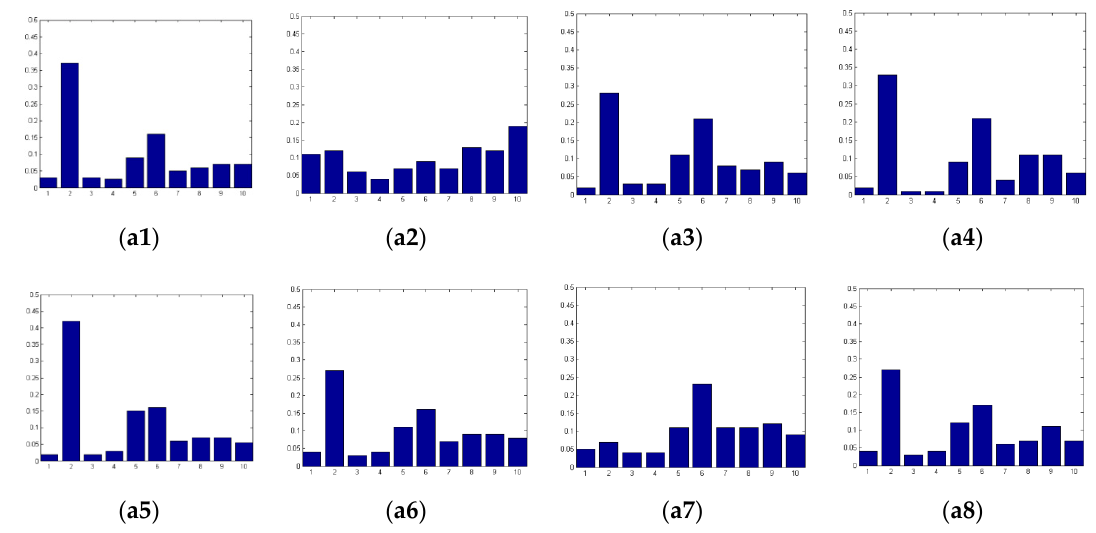
Figure 7. The examples of texture features of pictorial regions in the spatial domain; ( a1 – a8 ) are the second-order LDP histograms along the direction 0 ◦ of pictorial regions contained in the corresponding subgraphs ( a1 – a8 ) of Figure